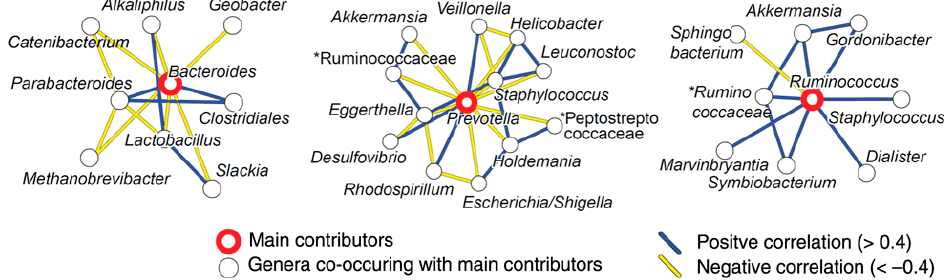
Figure 1. The human gut microbiota—main enterotypes [1,9]. Adapted from Arumugam et al. [9]. enterotypes. Unclassified genera under a higher rank are marked by asterisks [1,9]. Adapted from Arumugam et al.